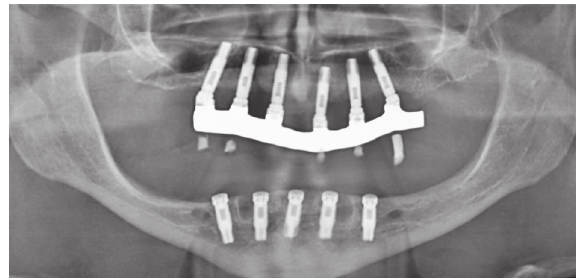
Figure 10: Control radiograph at 30 days.